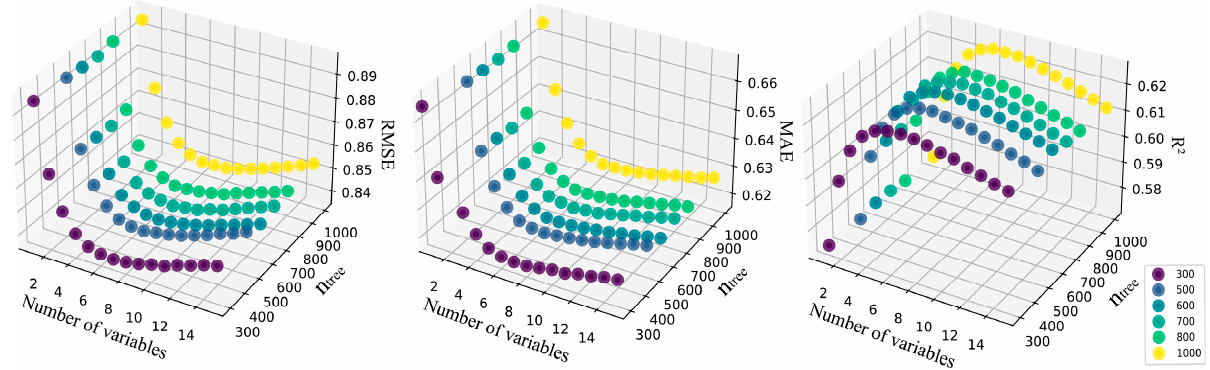
Figure 5. RF accuracy during the variable selection process using the different numerous trees (n tree ).